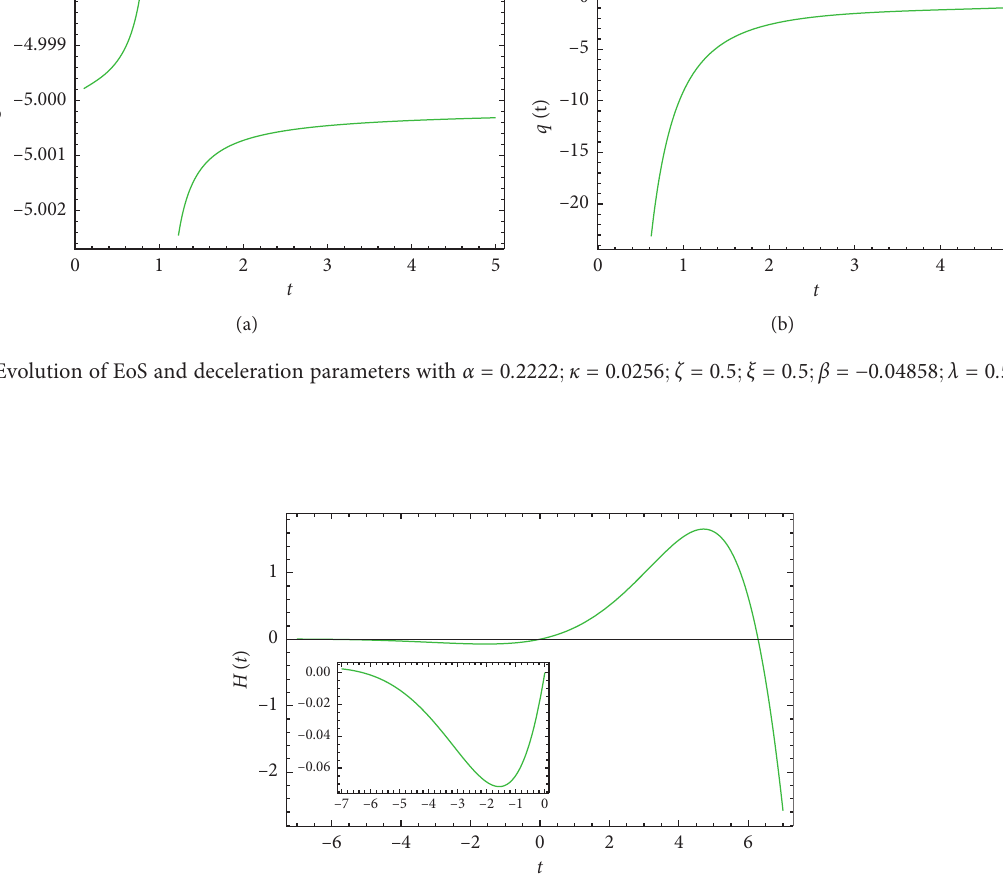
( t ) � ( r /Log t ) − s with α � 0 . 2222 ; κ � 0 . 0256 ; ζ � 0 . 5 ; ξ � 0 . 5 ; β � − 0 . 04858 ; λ � 2